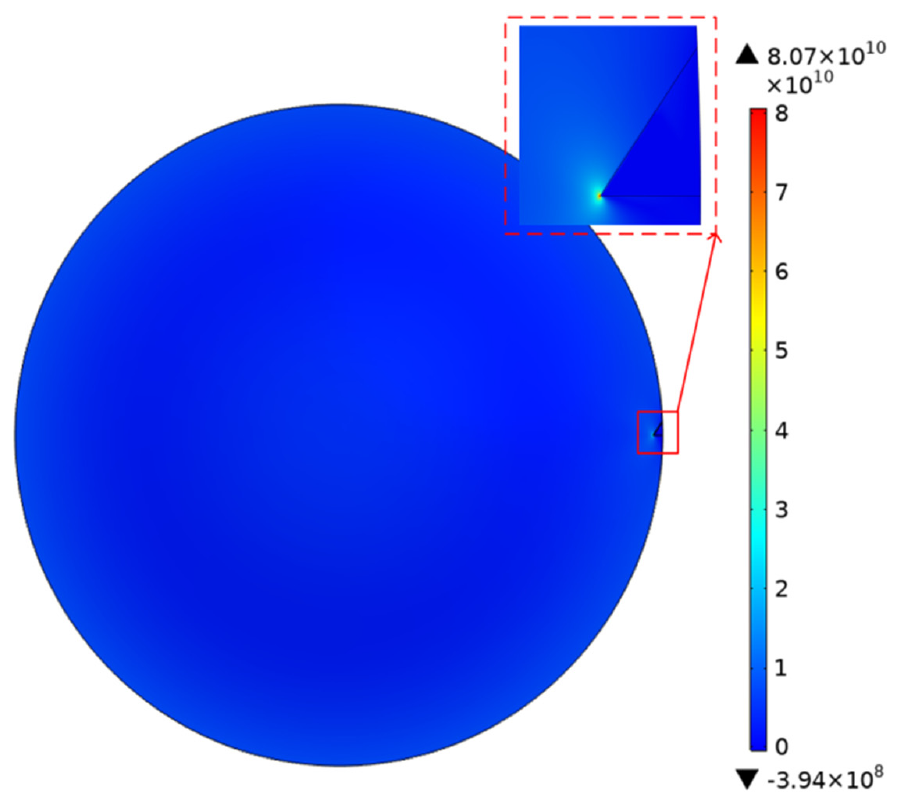
Figure 11. The simulation results of the film stress distribution when there are spikes on the edge of the substrate.